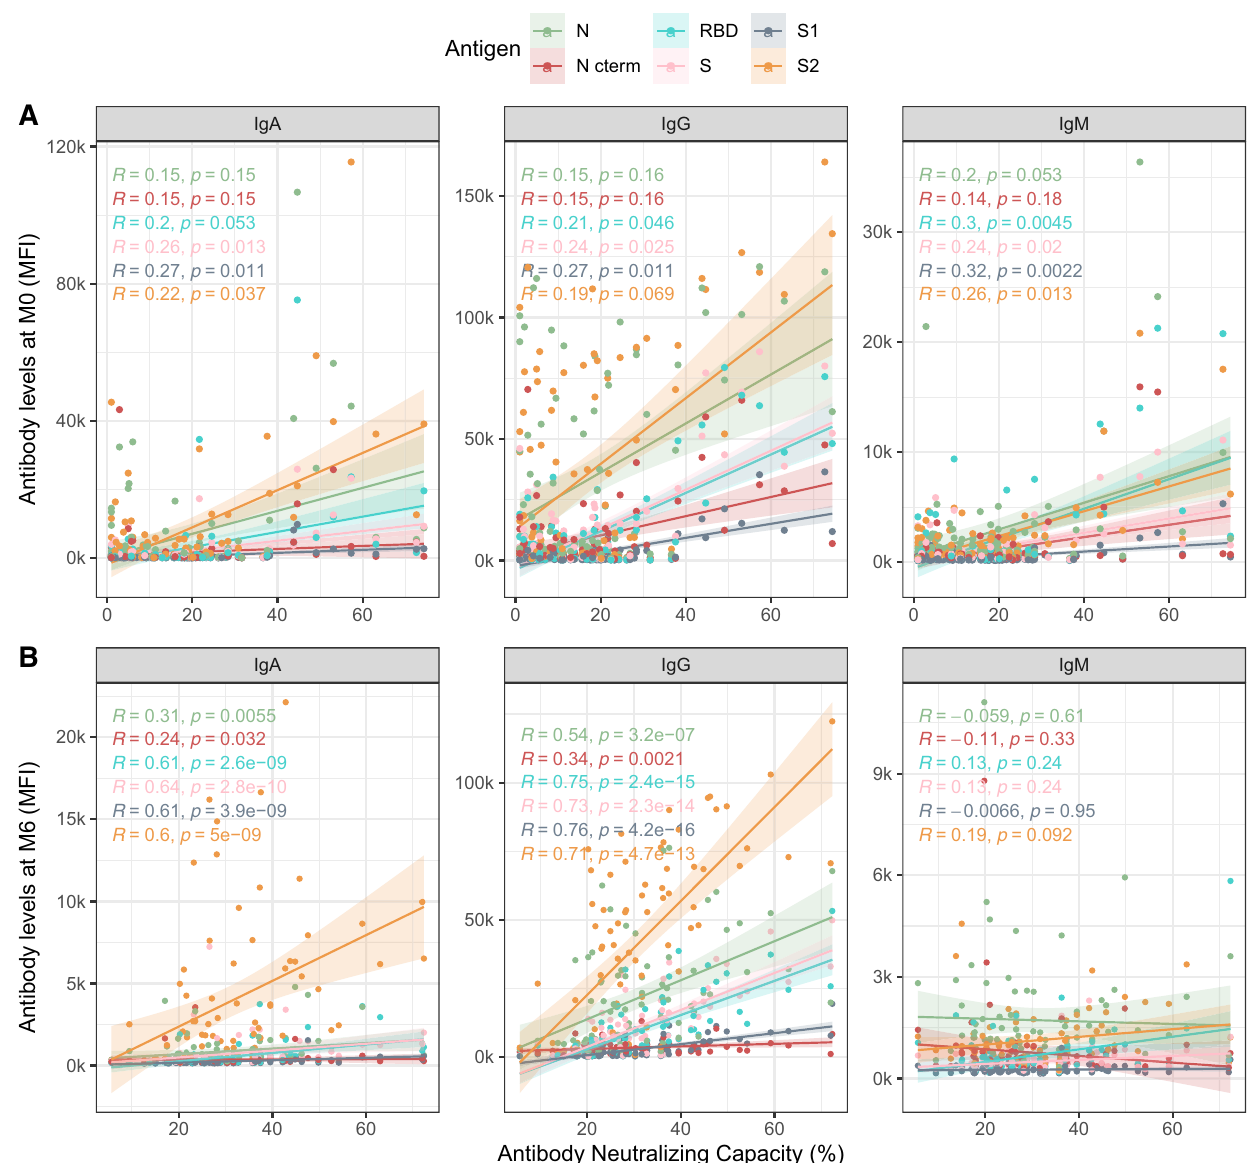
Fig. 3 Correlations between antibody levels and RBD-ACE2 neutralization capacity. Spearman ’ s rank correlation test between levels (median fl uorescence intensity, MFI) of IgA, IgG, and IgM against each antigen (Nucleocapsid full-length protein (N), and its C-terminal domain, the Receptor Binding Domain (RBD), full S protein and its subregions S1 and S2) at A baseline visit (M0) and B M6 visit; and plasma neutralization capacity (as a percentage of RBD-ACE2 binding inhibition). Two-sided spearman test was used to calculate the p -values and r s correlation coef fi cients are color-coded for each antigen/isotype pair. Colored lines represent the fi tted curve calculated using the linear model method. Shaded areas represent 95% con fi dence